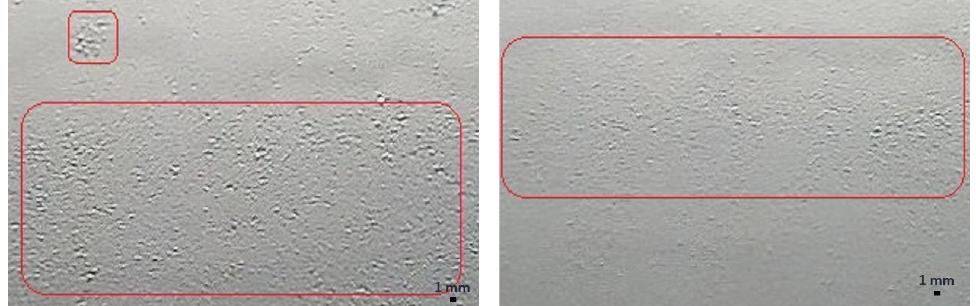
Figure 11. Example images of the reference surface with tiny water droplets during the dew onset